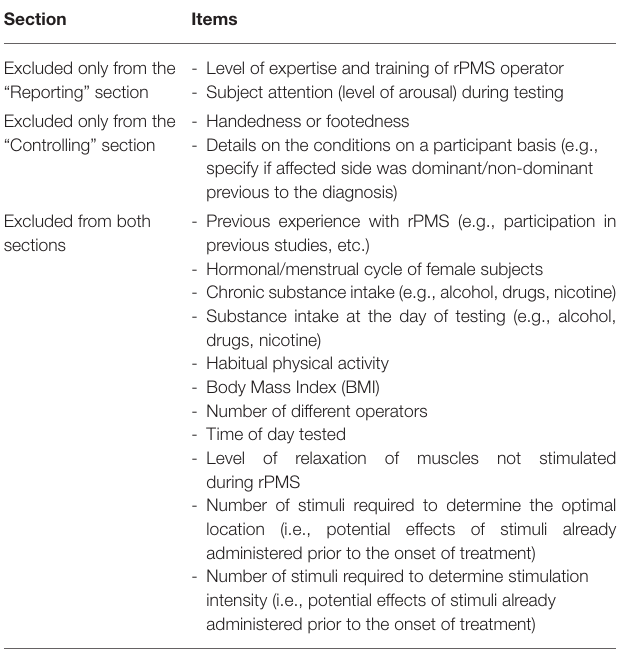
TABLE 3 | Items excluded from the checklist after the second round of the DELPHI study.